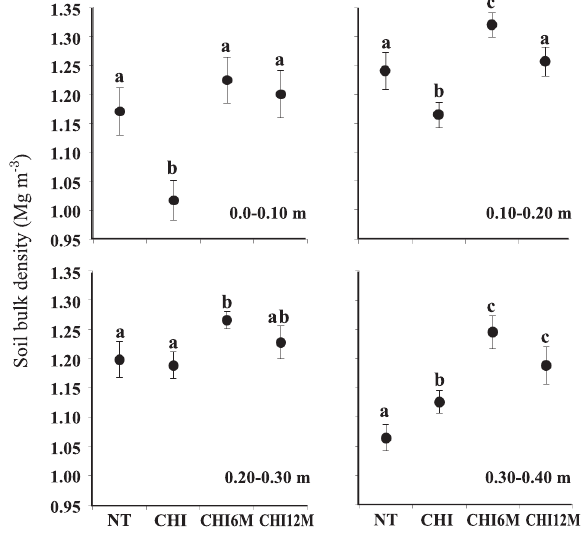
figure 3. mean values and respective confidence intervals for soil bulk density in the different sampling periods. nT: no-tillage before chiseling; chi: immediately after chiseling; chi6m: six months after chiseling; chi12m: 12 months after chiseling. same letters indicate overlap of the confidence